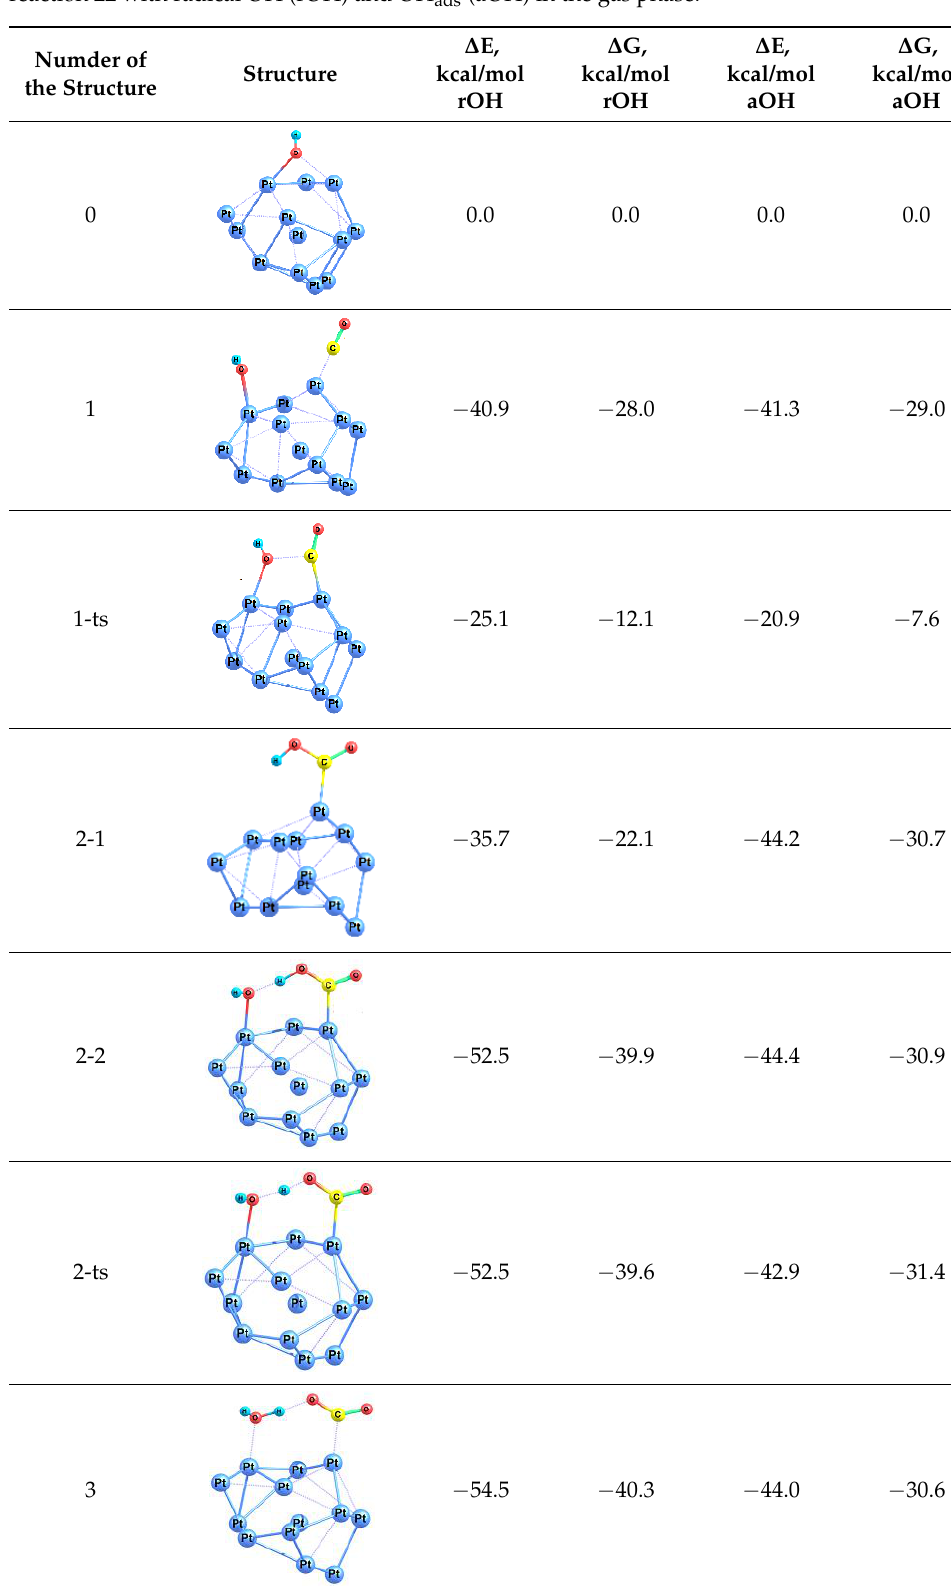
Table 3. The results of quantum-chemical calculations of the potential energy surface (PES) for reaction 22 with radical OH (rOH) and OH ads (aOH) in the gas phase.